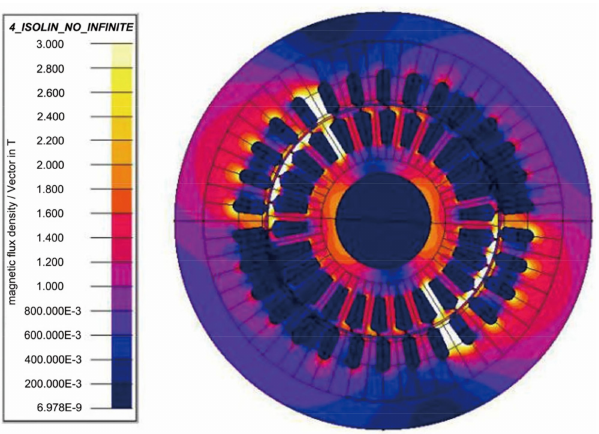
Figure 13. The distribution nephogram of flux density during normal operation of the motor.